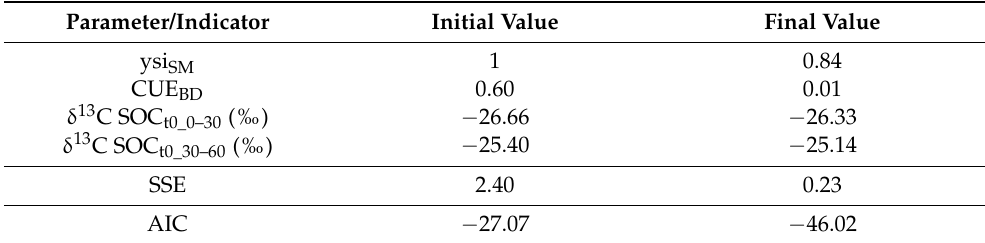
Table A4. Initial and final values of optimized parameters, the sum of squared errors (SSE), and Akaike’s information criterion (AIC). Parameters are listed in order according to the optimization